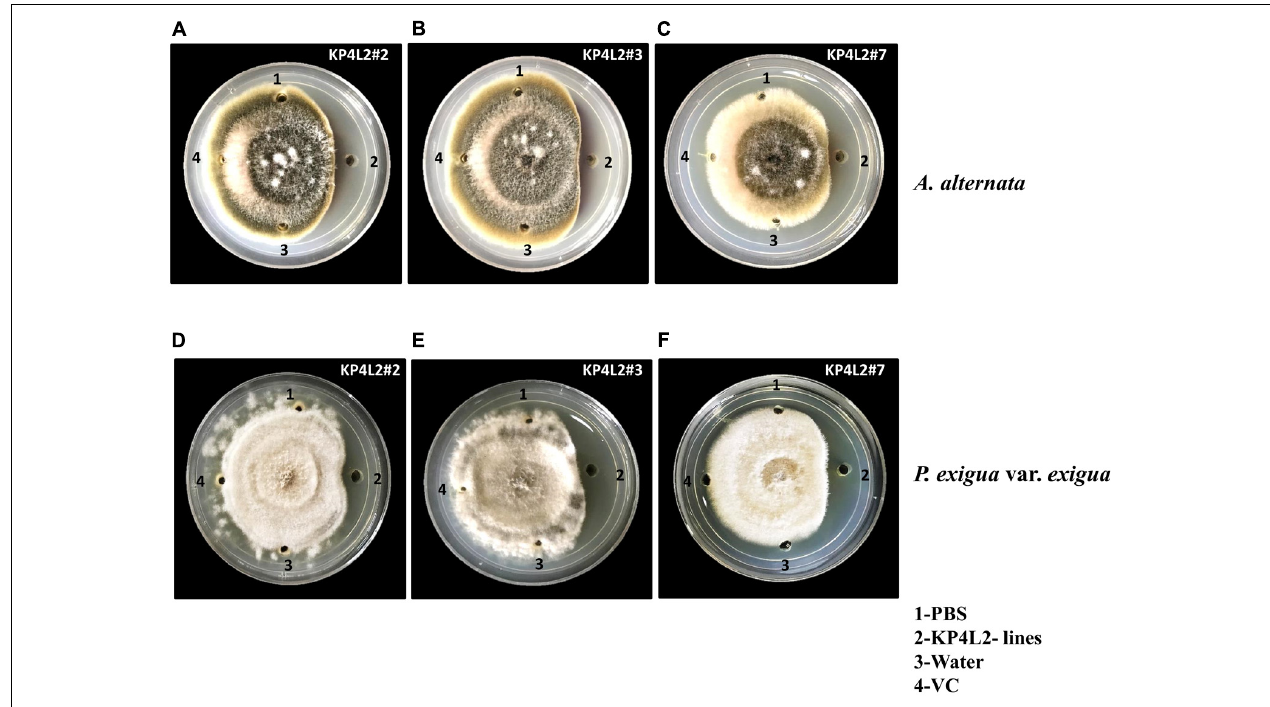
FIGURE 7 | In vitro agar plate diffusion assays against (A–C) Alternaria alternata and (D–F) Phoma exigua var. exigua . Here, wells on each side of the fungal growth represent the VC, KP4L2#2, KP4L2#3, and KP4L2#7 plant materials grounded in 1X sterile PBS along with sterile water and buffer (PBS) taken as controls.